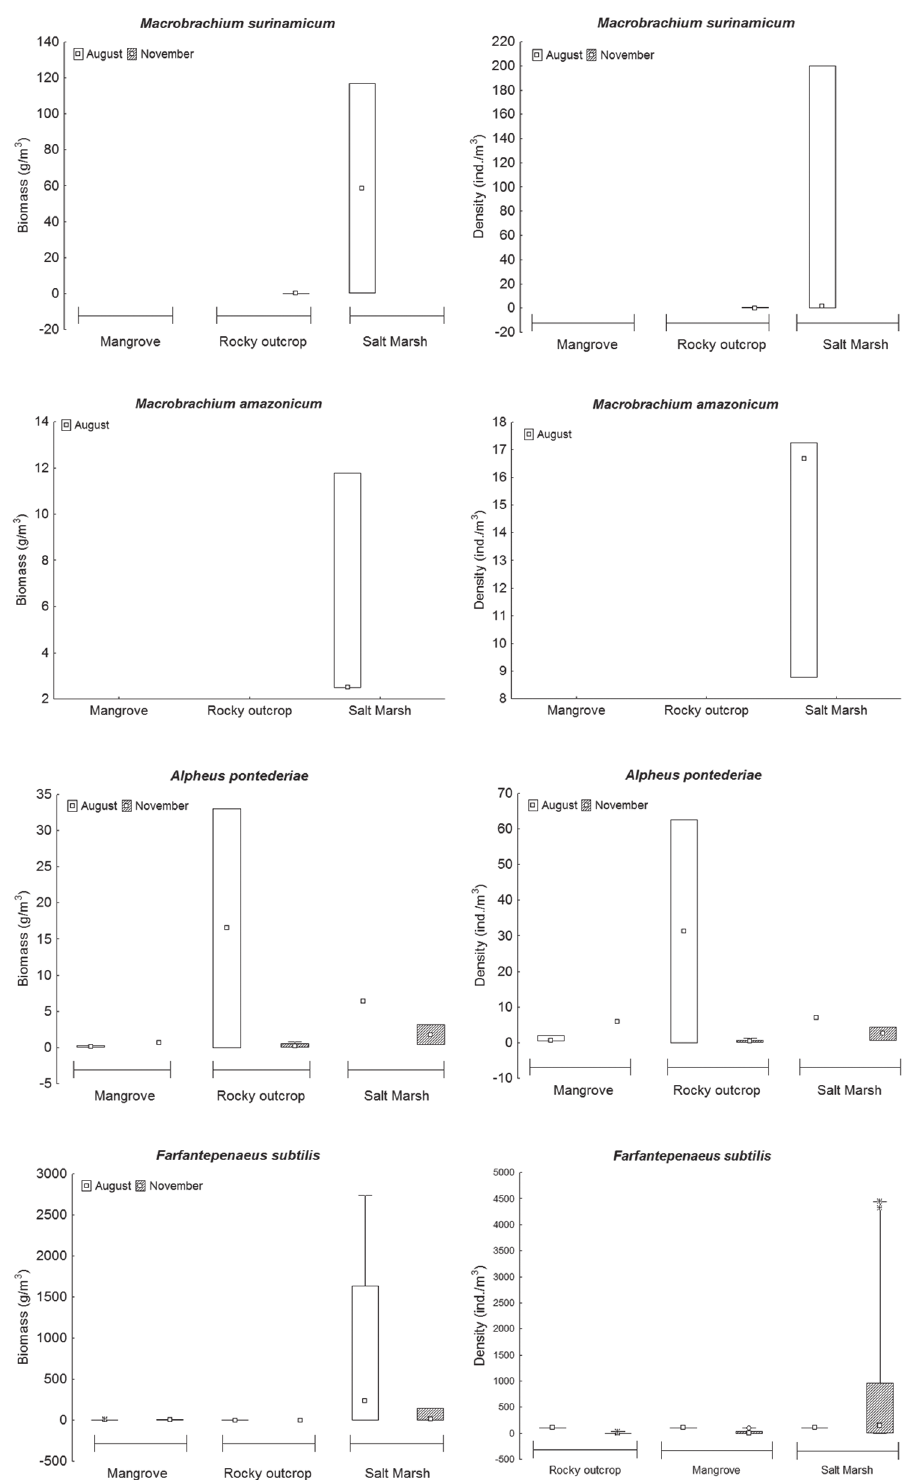
Figure 5 - Biomass (g/m 3 ) and density (ind/m 3 ) of species in relation to the habitats on Areuá Beach, Guarás Island, Curuçá, State of Pará, Brazilian